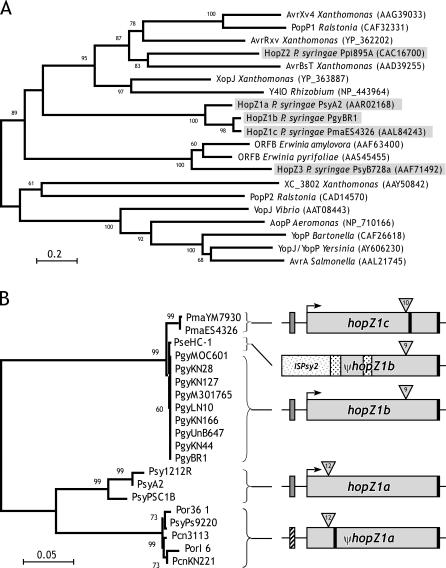
Phylogenetic Analyses(A) Neighbor-joining tree of YopJ family of T3SEs proteins. Bootstrap support is indicated above each node, with only values >60% being shown. T3SEs from P. syringae are highlighted. Accession numbers for each protein are presented in parentheses following the protein name and species.(B) Neighbor-joining gene genealogy of the hopZ1 T3SEs alleles with bootstrap analysis as above and hopZ2Ppi895A used as an out-group. The genetic organization of the three functional allele classes (hopZ1a, hopZ1b, and hopZ1c) and two degenerate hopZ1 alleles (ψhopZ1a and ψhopZ1b) are presented to the right of the gene genealogy. The large gray rectangle represents the region of shared similarity among the alleles, and corresponds to the coding sequence of hopZ1a. The dark vertical rectangle to the left of each gene represents the T3SS promoter element known as the hrp box. The solid black vertical line represents the stop codon for each allele. Arrows at the 5′ end of the coding sequences indicate which alleles are functional. Triangles above each coding sequence indicate insertions, with the insertion size indicated within. The ψhopZ1a allele has a nonsense mutation at nucleotide 171, and a degenerate hrp box in which the conserved GGAACC sequence has mutated to CCAACC. It is not transcribed under T3SS induction conditions. The ψhopZ1b allele is disrupted by an insertion sequence.